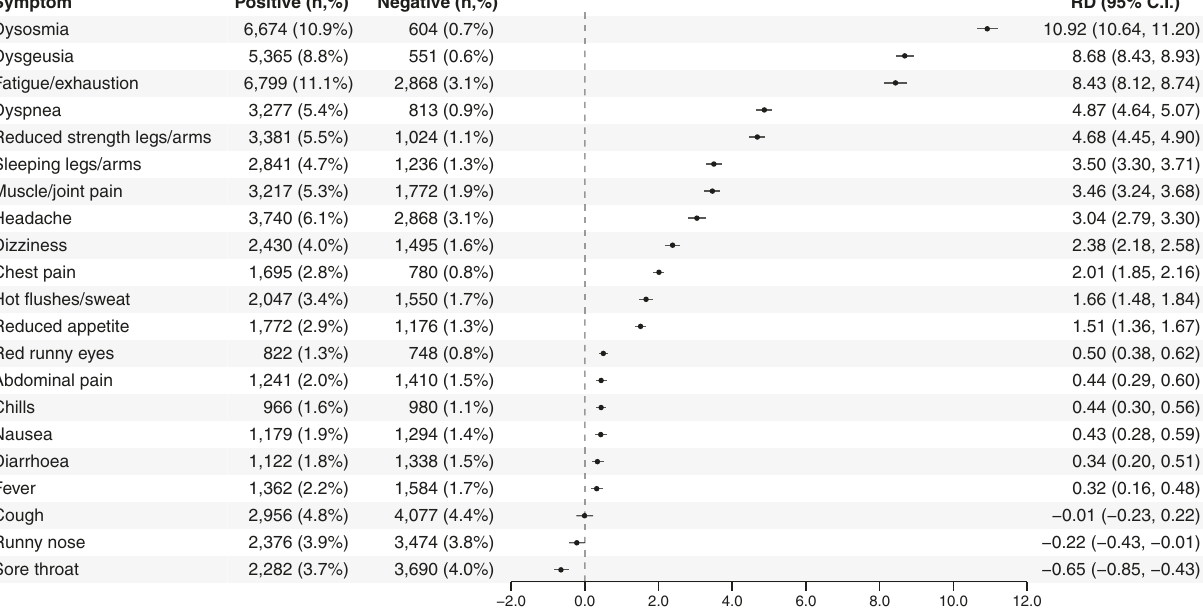
Fig. 1 Risk differences of symptoms after 6 – 12 months, comparing SARS-CoV-2 test-positive and test-negative participants. Note: Bars indicate risk differences (center) with 95% con fi dence intervals (length of error bars) adjusted for age, sex, comorbidities, obesity, healthcare occupation, and time after testing (in months). For post-acute symptoms 6 – 12 months after the test date, all test negatives no matter the indication for testing are used as the control population. All symptom questions were mandatory, so for all lines the proportions are based on 61,002 test-positive and 91,878 test-negative individuals. An individual could only participate in the study once, as either test-positive or test negative.